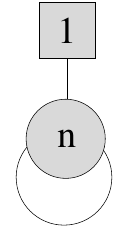
Figure 1 . The quiver for U(1)